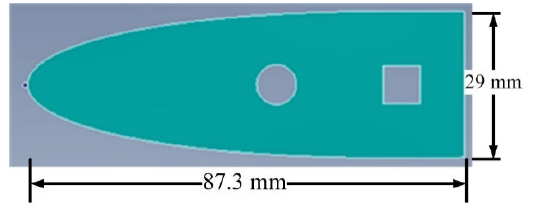
Figure 13. The riblet in Femap.